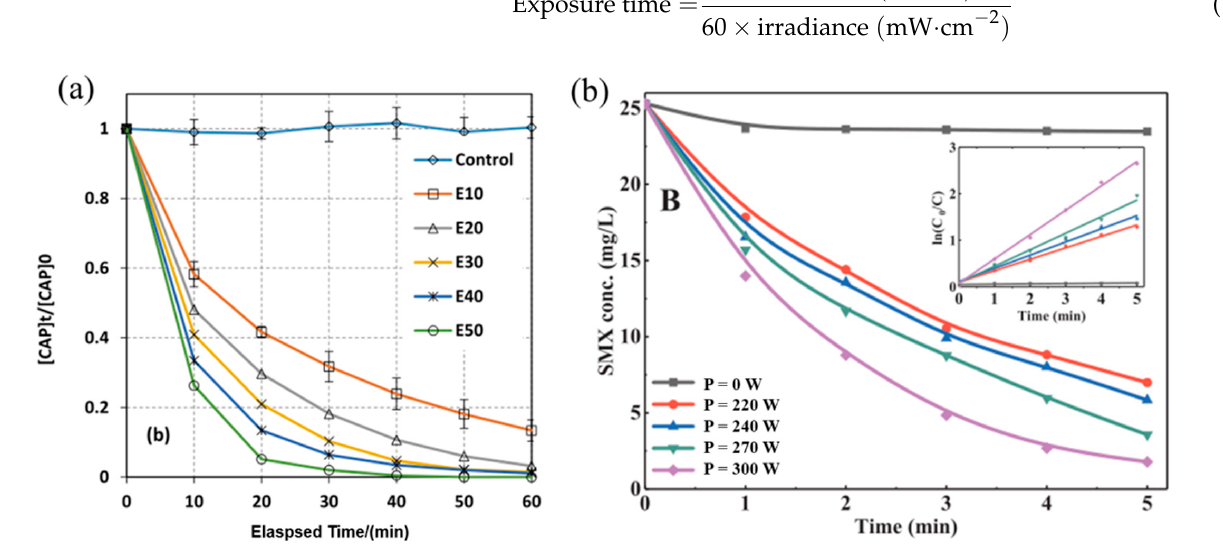
Figure 4. EffectofUVenergyonthedegradationofCAPandSMX( a )[CAP]=31 µ m; [PDS]=0.25mM[48]. Figure 4. Effect of UV energy on the degradation of CAP and SMX ( a ) [CAP] = 31 μ m; [PDS] = 0.25 ( b ) [PDS] = 2 mM; [SMX] = 0.1 mM; pH = 7.0 [57]. Copyright (2020), with permission from mM. [48]( b ) [PDS] = 2 mM; [SMX] = 0.1 mM; pH = 7.0 [57].Copyright (2020), with permission from